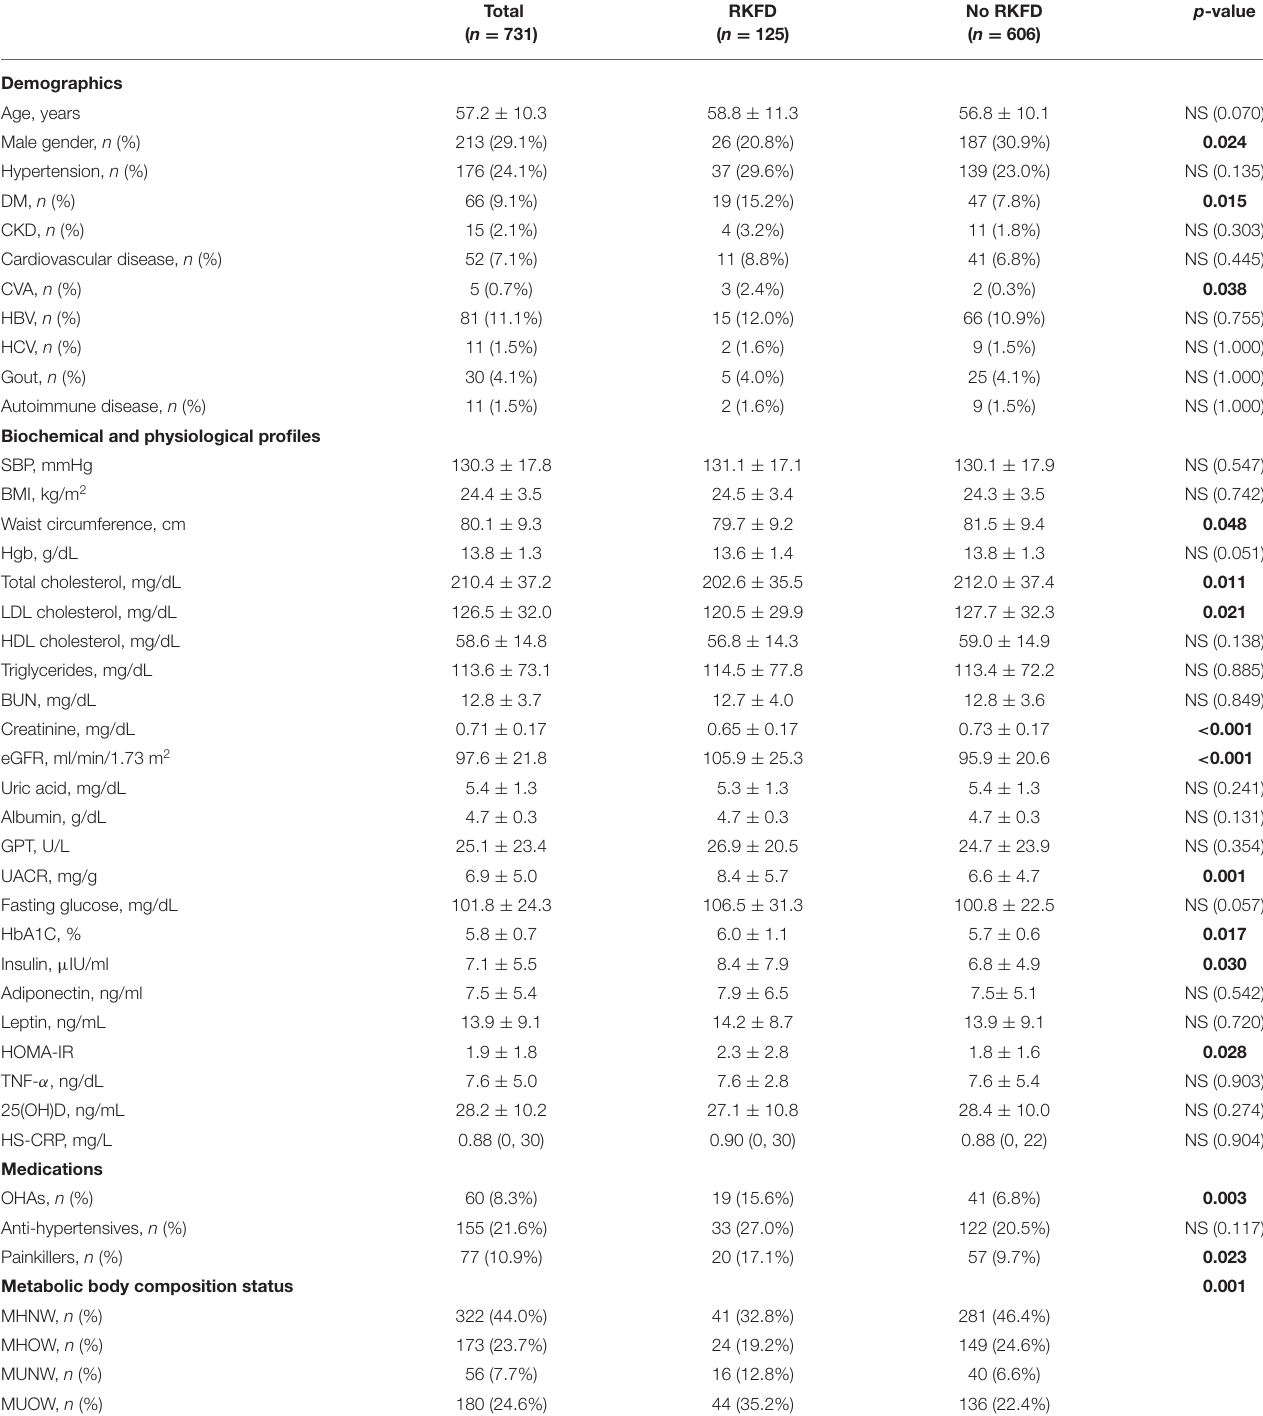
TABLE 1 | Baseline characteristics of the study